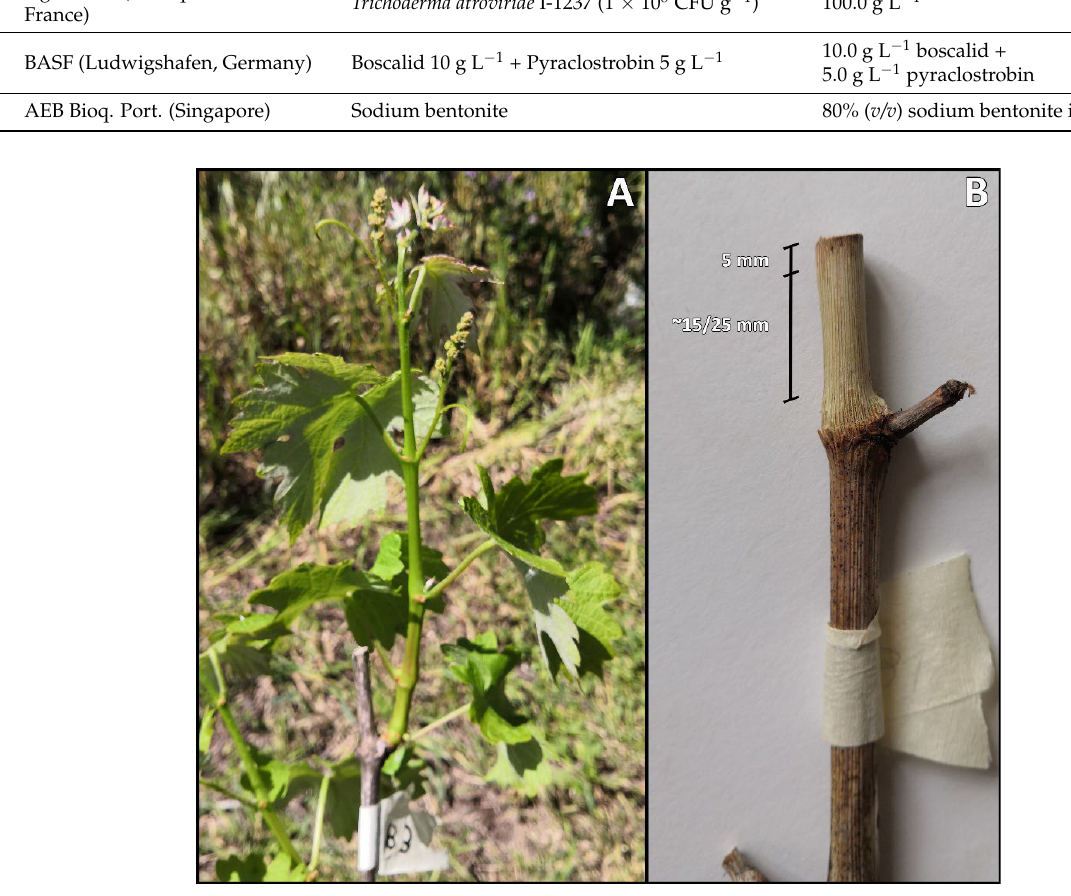
Figure 1. Grapevine shoot (cv. Syrah) at phenological stage 13—inflorescence clearly visible, 6 leaves separated—Almotivo vineyard ( A ). Treated grapevine cane deprived of the bark in the area of interest ( B ). The upper 5 mm of wood was discarded, while the following ~15 mm of wood was cut into small pieces and ground to